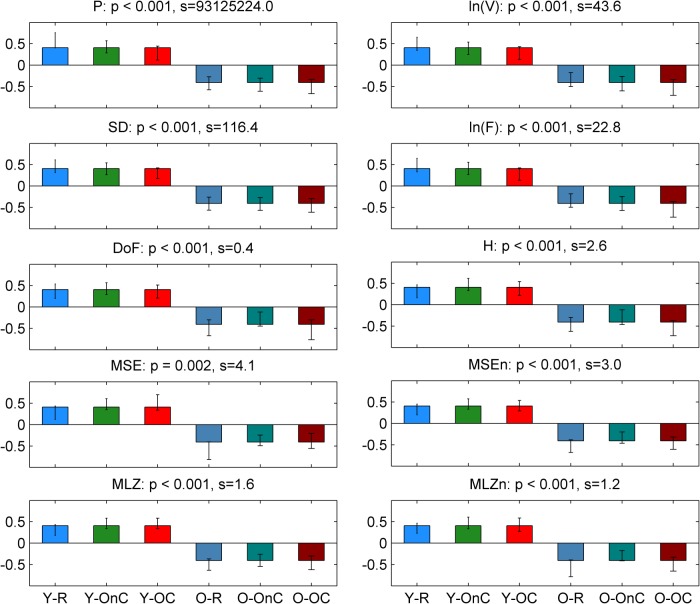
Task latent variables for the group main effect. Each panel shows the weights of the task latent variables of the contrast that corresponds to the group main effect Y-O. Each bar corresponds to a group-condition combination, with groups being arranged in increasing age from left to right, and conditions arranged in an order of increasing attention and/or task demands (i.e., from R to OC), also from left to right. Color conventions are identical to previous figures. The name of each metric together with the corresponding p value (as derived from the parametric test for significance) and the singular value s of the SVD (proportional to the variance explained by the contrast) are shown on top of the respective panel. Nonoverlapping confidence intervals signify that conditions and/or groups are separated reliably by the contrast. Thus, the contrast is significant and reliably separates the two groups.